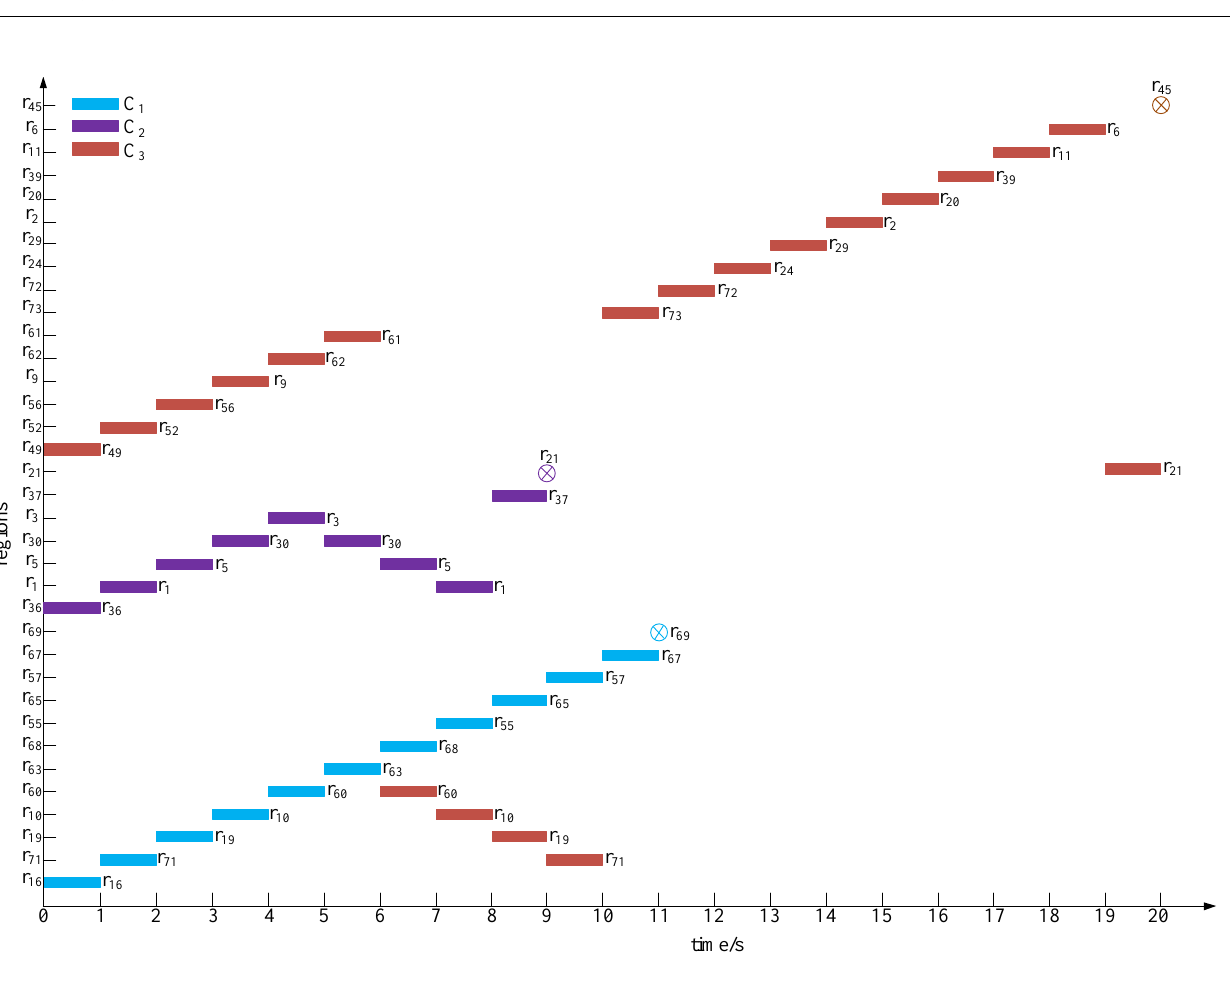
Figure 5. Gantt chart of the obtained paths.